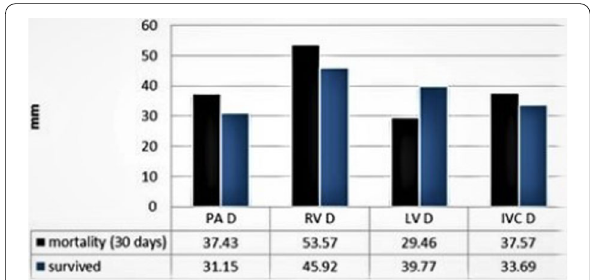
Fig. 1 CT measurements in patients with 30‑day mortality versus patients who